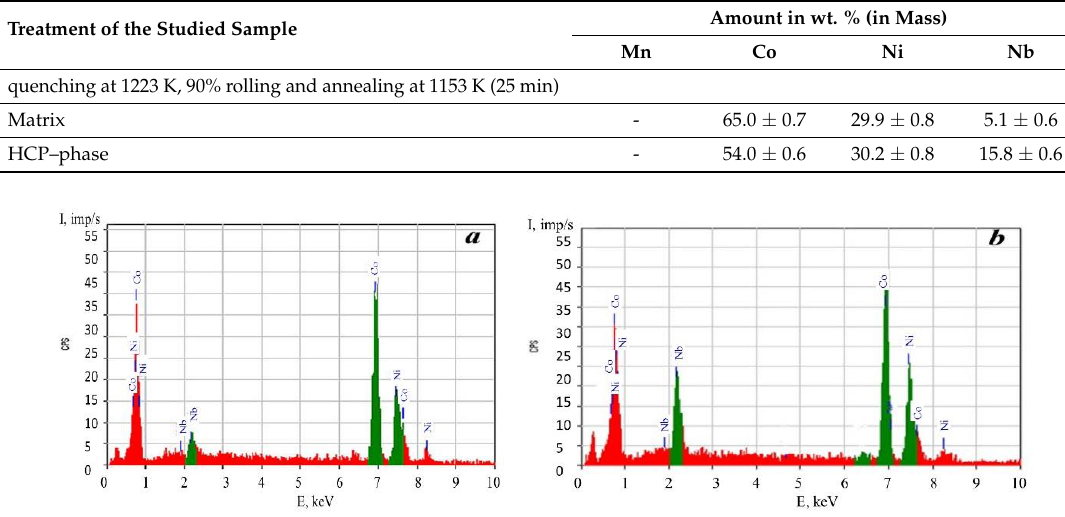
Figure 7. X-ray fluorescence spectra of the Co-Ni-Nb alloy measured in matrix ( a ) and particle ( b ) of secondary phase.